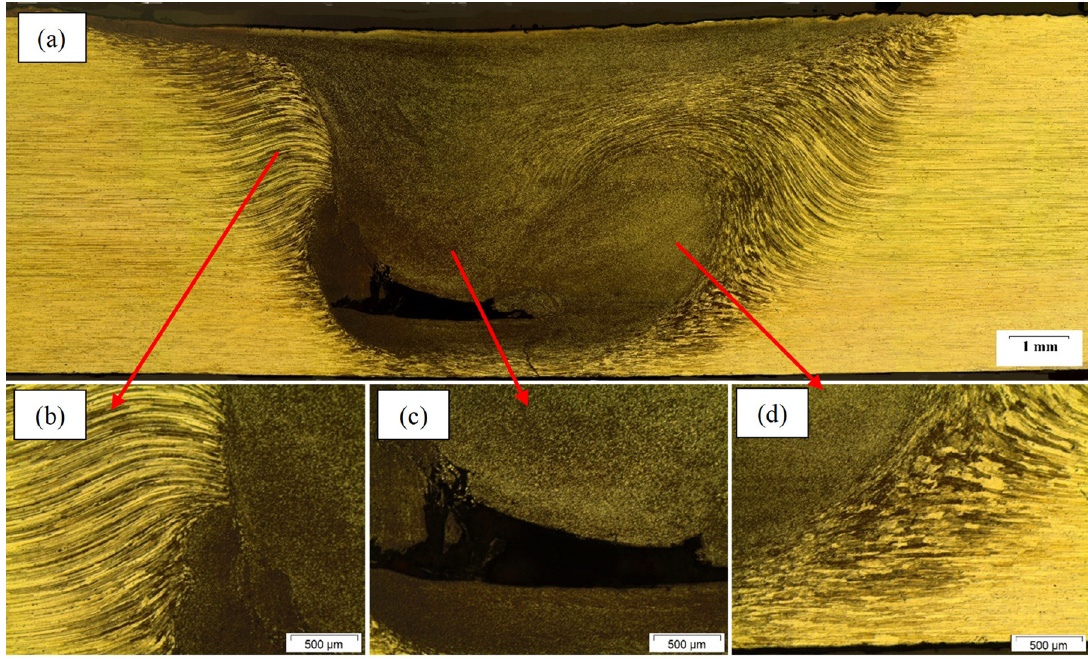
Figure 7. Macro and microstructure of the weld joint 2: (a) Macrograph of the cross section, (b) Micrograph of the region between TMAZ and SZ on the retreating side, (c) SZ and welding defect, and (d) boundary between SZ and TMAZ on the advance “kissing bond”, Figure 8d. As occurred in welded joint 2, the wormhole defect is located on the retreating side of the tool.